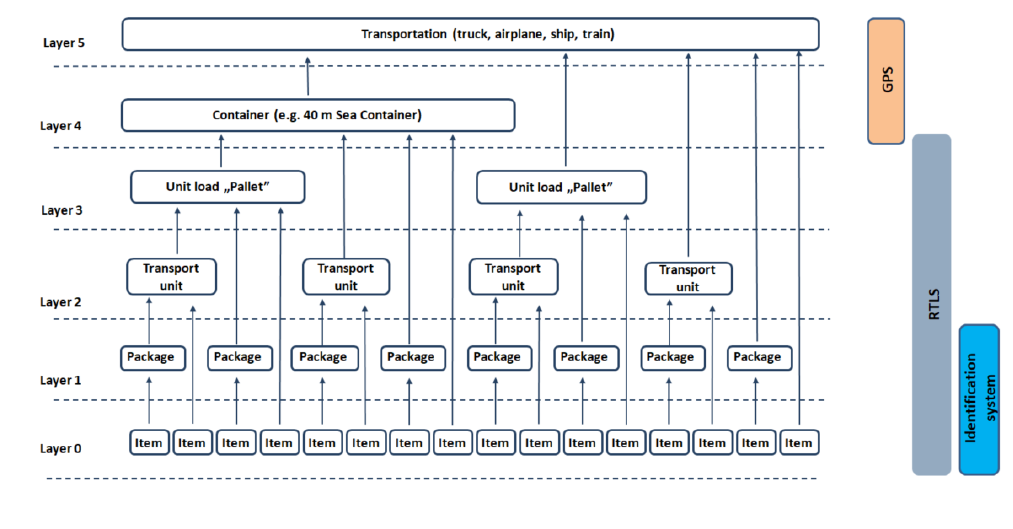
Figure 2. Identification levels in a production system. Layers define the logistic units from raw material (items) to trucks